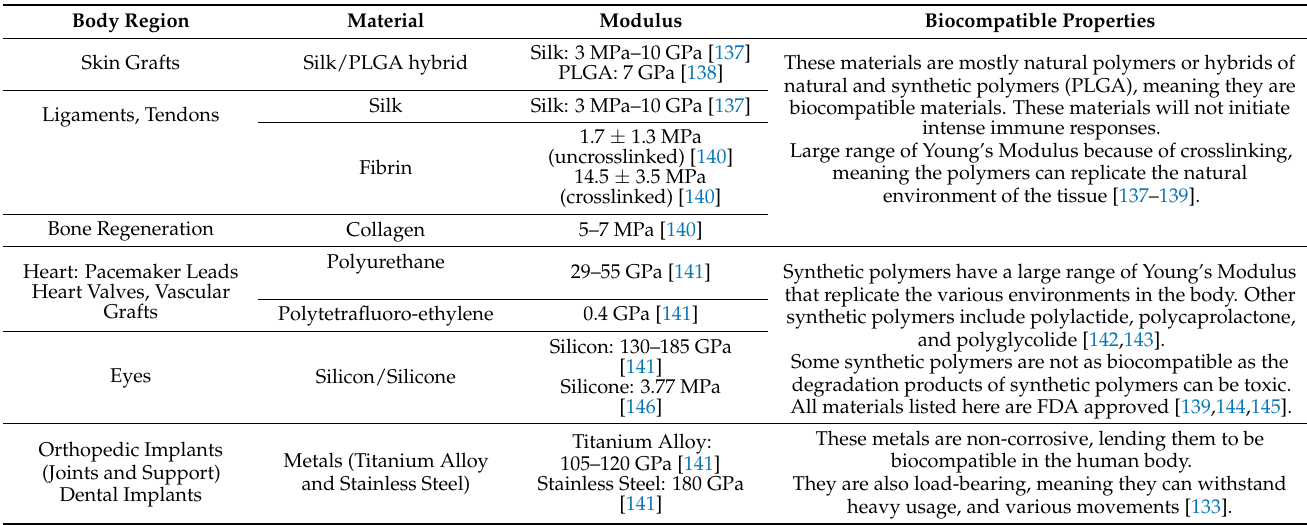
Table 1. Overview of biocompatibility, modulus, and applications of implantable